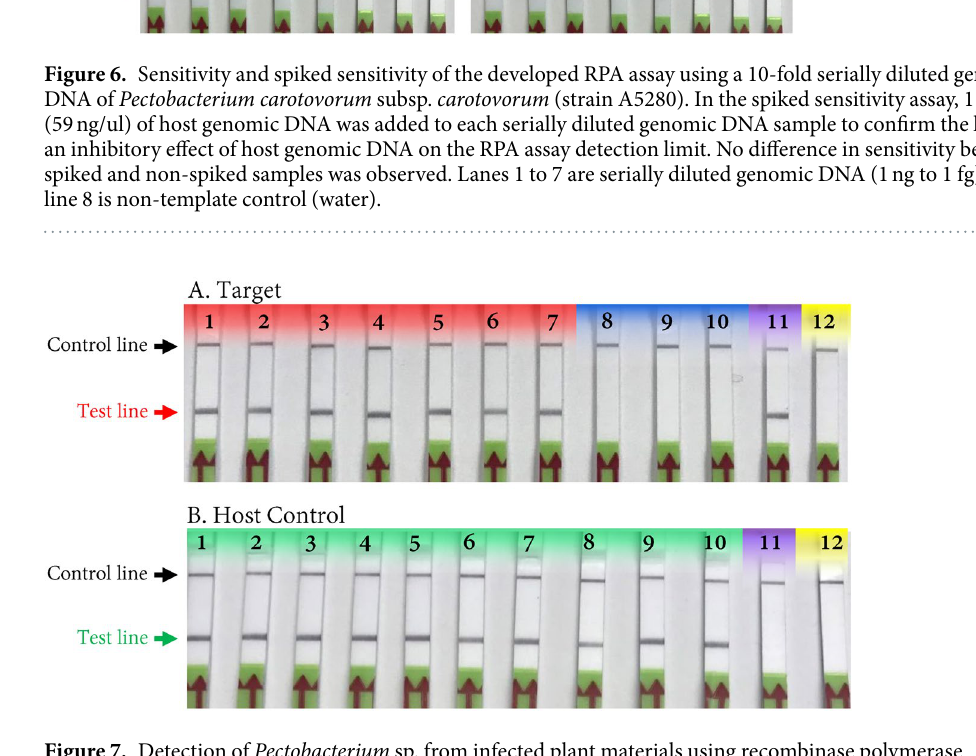
Figure 7. Detection of Pectobacterium sp. from infected plant materials using recombinase polymerase amplification (RPA). ( A ) Detection of the target pathogen ( Pectobacterium sp.) using Pectobacterium -specific RPA assay; ( B ) detection of host DNA using host specific RPA assay as a host control. Lane 1 - Pectobacterium carotovorum subsp. carotovorum (A5280); lane 2 - P . carotovorum subsp. carotovorum (A5278); lane 3 - P . carotovorum subsp. carotovorum (A5368); lane 4 - P . carotovorum subsp. brasiliensi s (A2688); lane 5 - P . carotovorum subsp. brasiliensis (A3048); lane 6 - P . carotovorum subsp. carotovorum (A5278); lane 7 - P . carotovorum subsp. carotovorum (A5368); lane 8 - Dickeya chrysanthemi (A5415); lane 9 - D . solani (A5581); lane 10 – D . solani (A5582): lane 11 - P . carotovorum subsp. carotovorum (A5280; positive control – DNA from pure culture); 12) non-template control (NTC; water). Only DNAs of Pectobacterium sp. reacted postively and produced a line with the target specific RPA assay. Samples 1–5 were tomato inoculated with Pectobacterium sp., samples 6–7 were potato tubers inoculated with Pectobacterium sp. and samples 8–10 were potato tubers inoculated with Dickeya sp. Color codes: red – Pectobacterium sp. detected; blue – no detection; purple – positive control for Pectobacterium specific RPA assay but it is a negative control for host-specific RPA; green – host DNA detection; yellow – NTC.